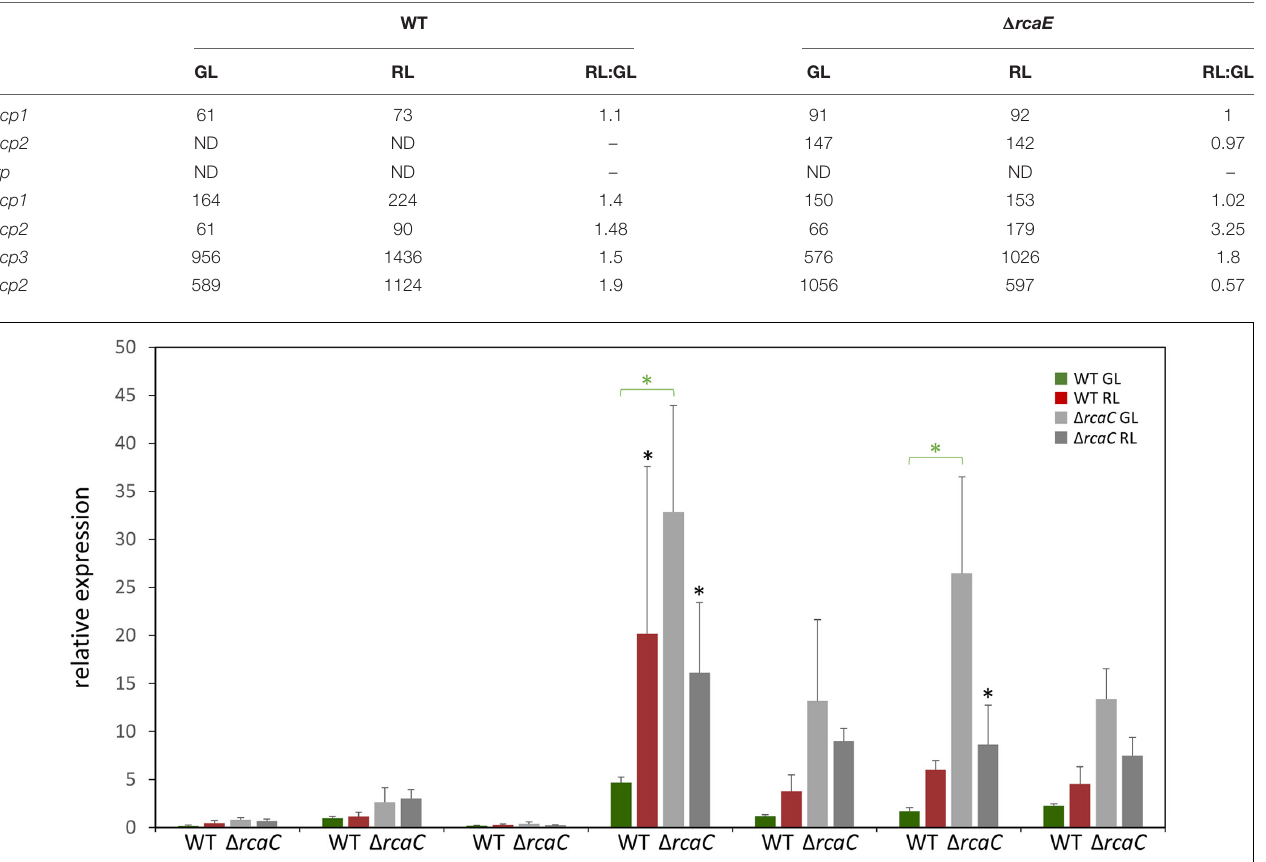
TABLE 2 | RNA-sequencing-based analysis of expression of orange carotenoid protein (OCP), fluorescence recovery protein (FRP), helical carotenoid proteins (HCP), and C-terminal domain-like carotenoid protein (CCP) homologs in wild-type (WT) and RcaE photoreceptor-deficient strains of chromatically-acclimating Fremyella diplosiphon grown under green light (GL), red light (RL), or for RL vs. GL (RL:GL) counts for each strain.